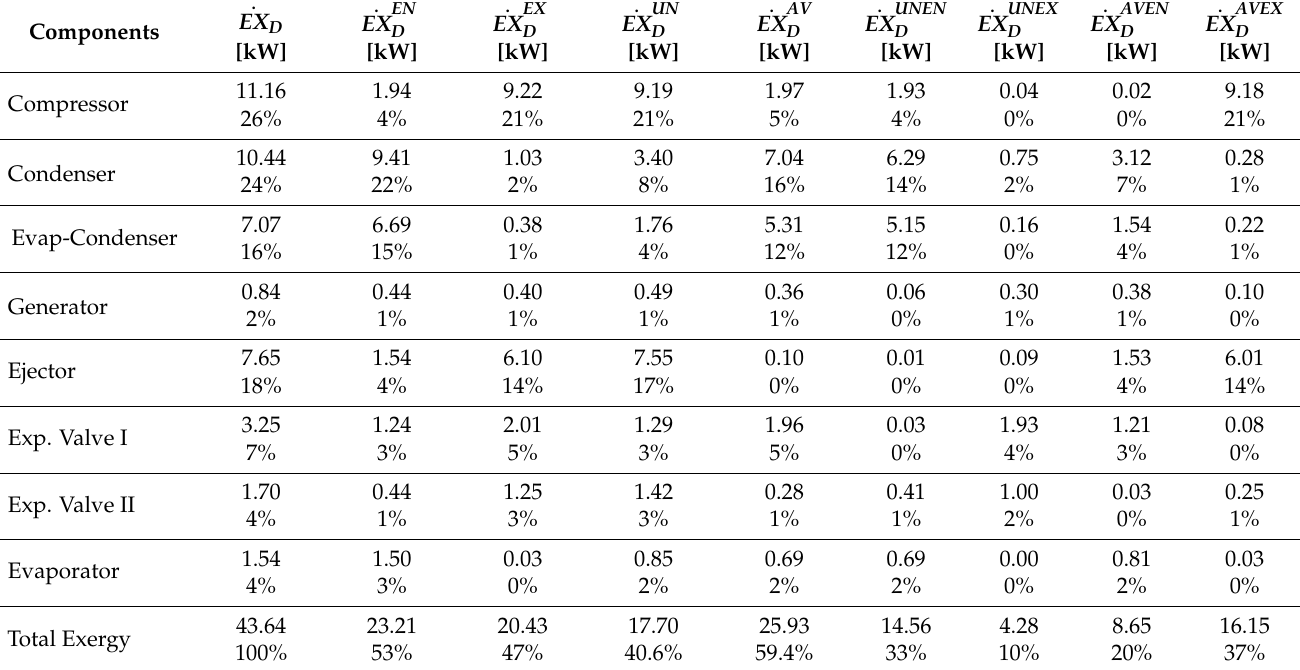
Table 7. Advanced exergy analysis of the main system